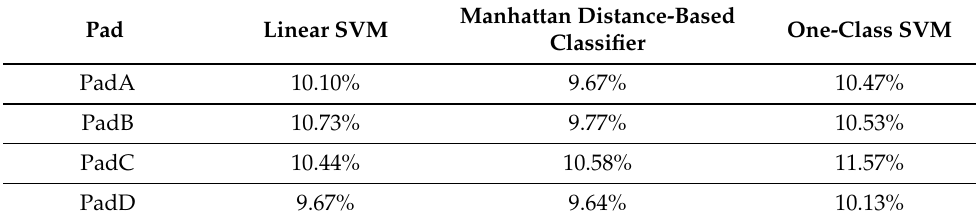
Figure 10. EER for removal of the lower 50% features. Table 8. EER for removal of the lower 50%